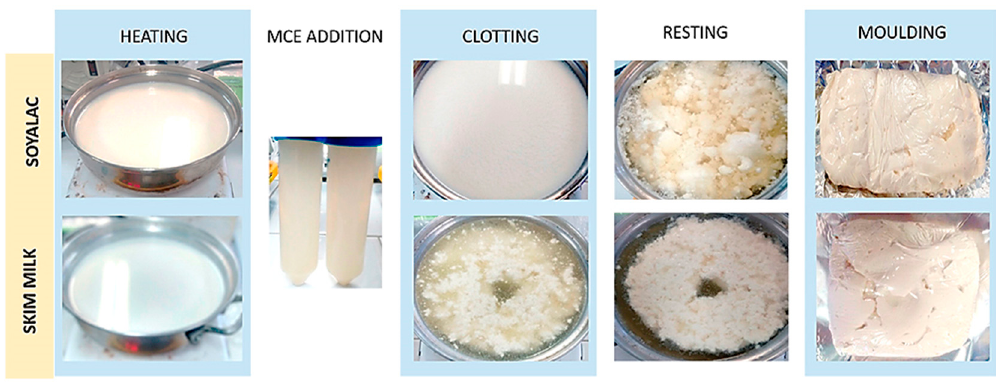
Figure 7. Workflow employed in cheese making using seed crude extract. The upper photos show soy milk cheese’s elaboration while the lower photos show skim milk cheese’s elaboration, both processed with Moringa seed extract. All experiments were performed in triplicate.